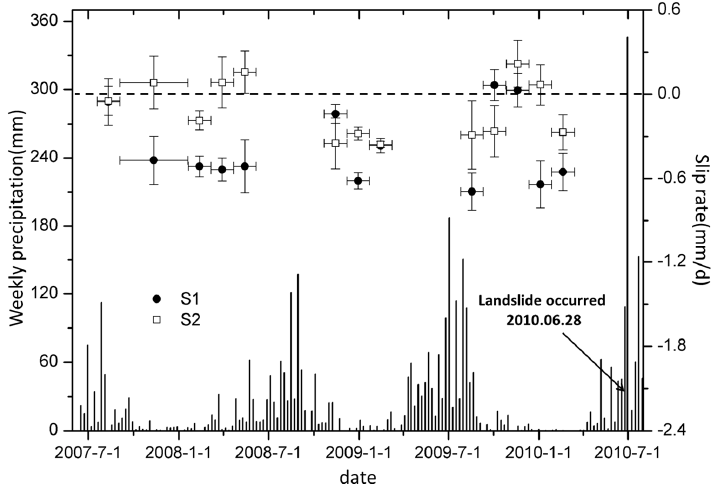
Figure 10. Time-series deformation rate in the downslope direction of regions S1 and S2 (shown in Figure 8), where the rainfall data in the study area is shown by weekly statistics. Error bars in the y-axis represent the heterogeneity of the slip rate in the selected regions. Horizontal bars in the x-axis represent the time interval between the adjacent SAR acquisition dates.